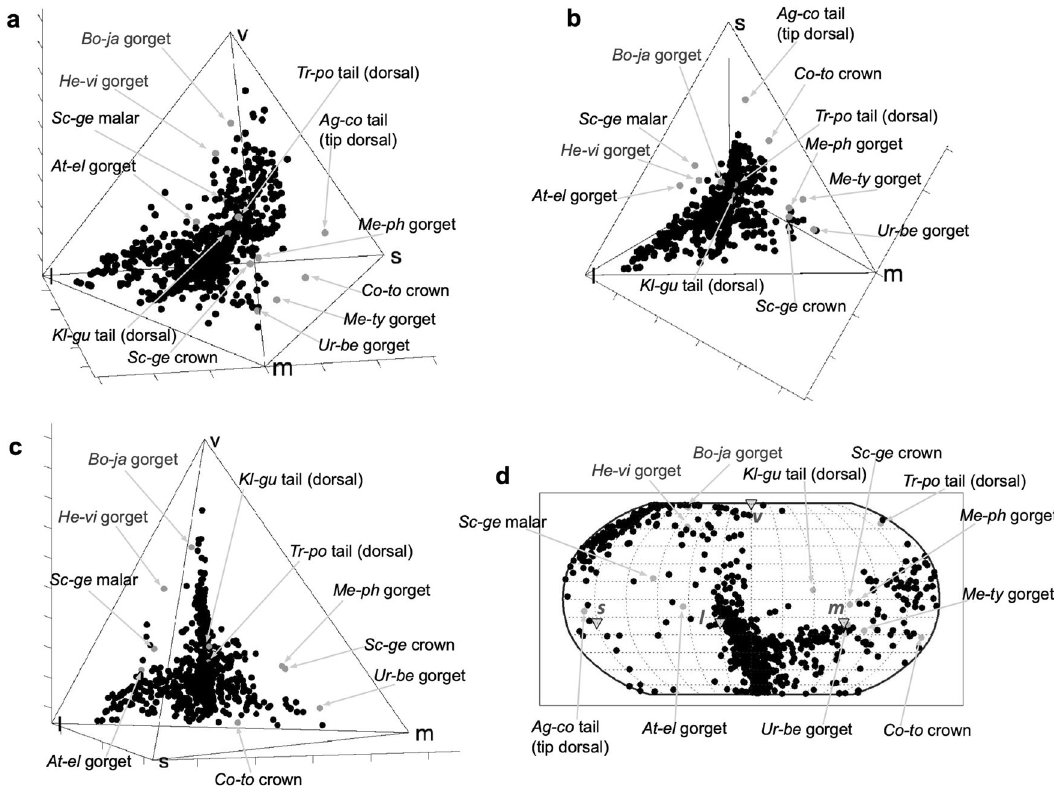
Fig. 5 Distribution of unusual hummingbird plumage spectra in color space. Unusual hummingbird plumage spectra (gray) from Fig. 4 with the total avian color gamut (black) from Stoddard and Prum (2011) a – c plotted in avian VS color space and viewed from three angles: a standard view, b a top-down view, and c a view toward the l-m edge from slightly below. d Robinson projection of the hues of the same color points. All spectra are labeled with the fi